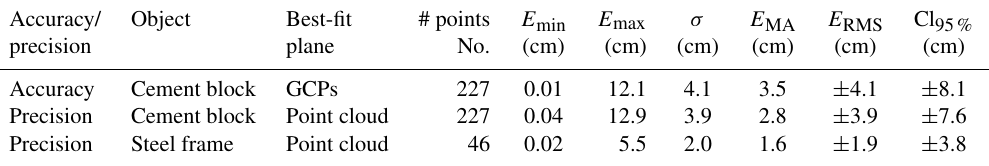
Table 1. Vertical accuracy and precision of the lidar point measurements, in terms of minimum error ( E min ), maximum error ( E max ), standard deviation ( σ ), mean absolute error ( E MA ), root mean square error ( E RMS ) and the 95% confidence level (Cl 95% ). Accuracy/